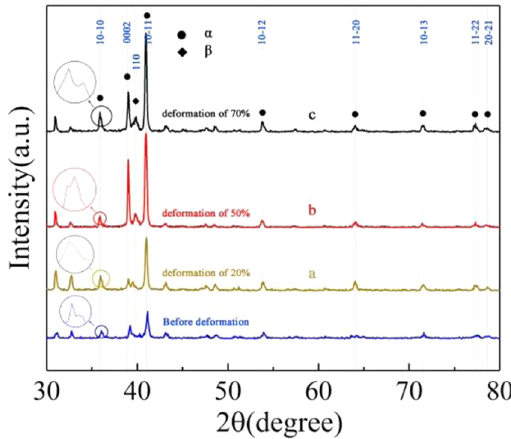
Figure 5: XRD patterns of the TC4 titanium alloy at di ff erent amounts of deformation: ( a ) one - pass, ( b ) two - pass and ( c ) three -